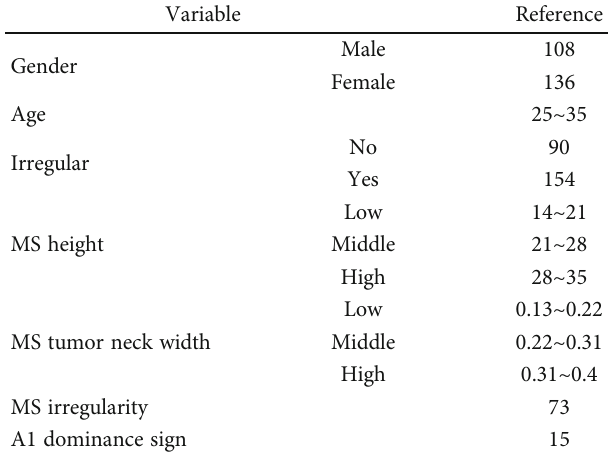
Table 1: Multifactor logistic regression analysis of the two groups of patients in the training